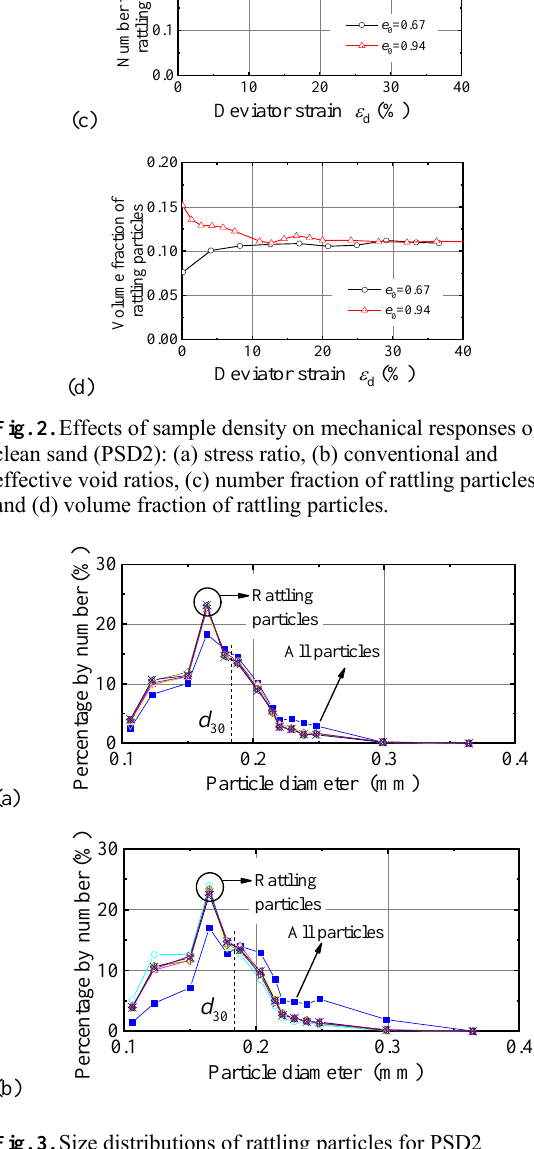
Fig. 3. Size distributions of rattling particles for PSD2 samples: (a) e 0 = 0.94 and (b) e 0 = 0.67.